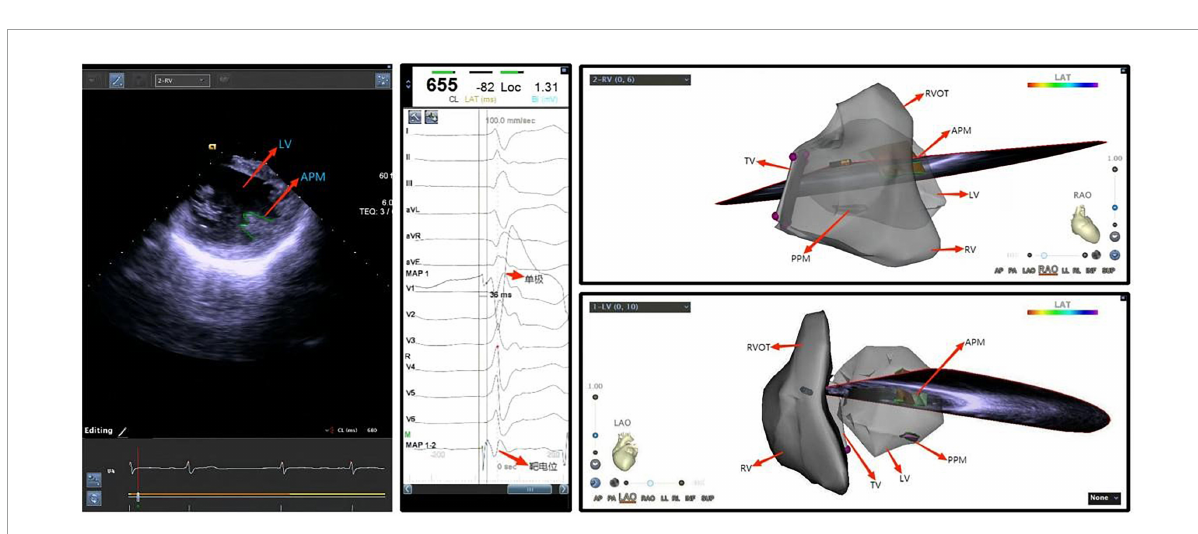
FIGURE6 Ventricular premature beat of left ventricular anterior papillary muscle. LV, left ventricle; APM, anterior papillary muscle; TV, tricuspid valve; PVOT, right ventricular outflow tract; PPM, posterior papillary muscle; RV, right ventricle; LV, left